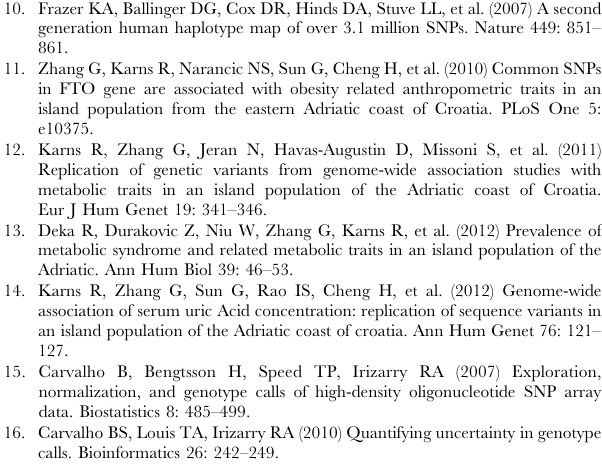
Figure S1 Distribution of distance between the primary and secondary SNPs. (TIF) Figure S2 Correlation between secondary effect and primary effect. (TIF) Figure S3 Distribution of height in females (N =739) and males (N =565). (TIF) Table S1 Effect sizes of the 180 height-associated SNPs reported by Lango Allen et al. [ Nature 467 (7317): 832–8]. Table S2 Effect sizes and p-values of the 19 secondary signals